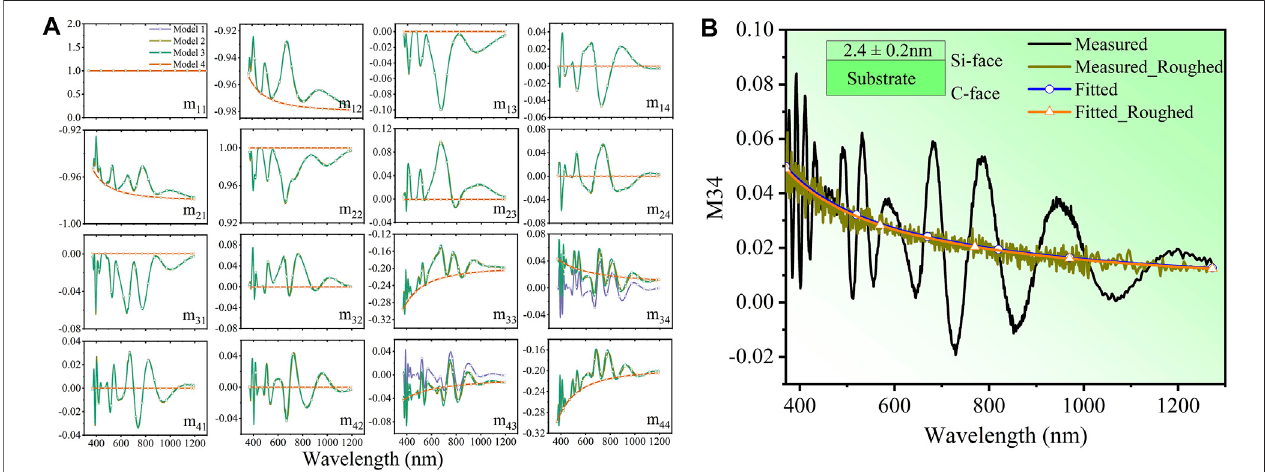
FIGURE4| ThesimulationoftheMuellermatrix. (A) Model1,350 μ m4H-SiCthicklayerwithbacksidere fl ection.Model2,2 nmSiO 2 layerontheSi-faceofthe4H- SiC thick layer with backside re fl ection. Model 3, 2 and 5 nm SiO 2 layers on the Si-face and the C-face of the 4H-SiC thick layer with backside re fl ection. Model 4, 2 nm SiO 2 layersontheSi-faceofthe4H-SiCsemi-in fi nitesubstratewithoutbacksidere fl ection.Theangleofincidenceis65 ° andtheEulerangle γ is45 ° , β is4 ° . (B) Measured and fi tted M34 elements of the backside polished and roughed wafer by using the same semi-in fi nite substrate model.